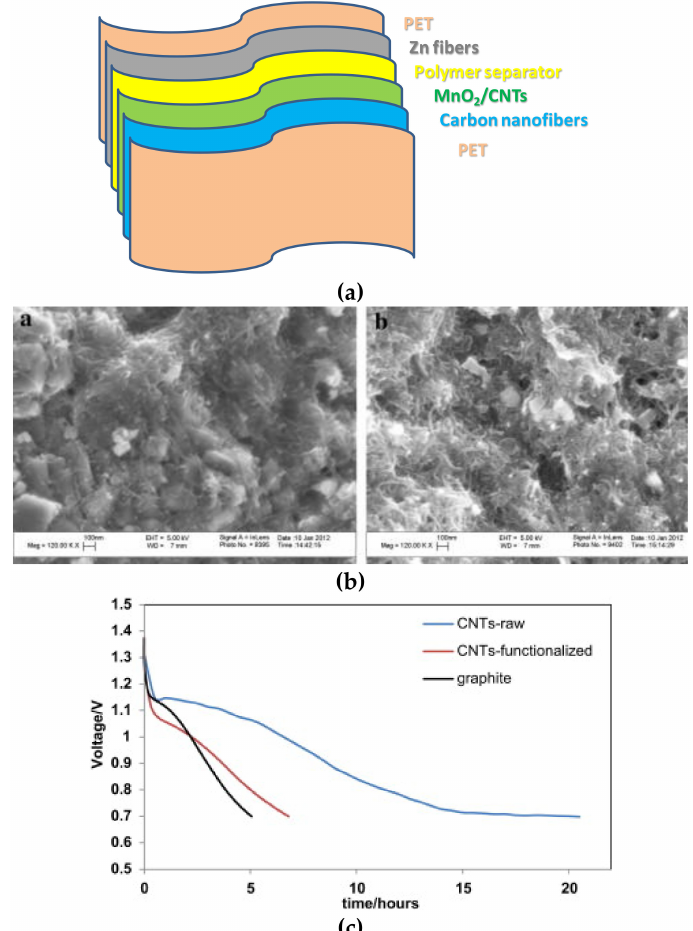
Figure 5. ( a ) Sketch of the typical components of a flexible Zn–carbon battery; ( b ) SEM micrographs of MnO 2 -cathode containing functionalized MWCNTs (left) and Zn particulate anode (right); ( c ) Zn–C discharge curves for di ff erent cathodes at the same load (8.6% w / w ). Panels ( b , c ) are reprinted from reference [146], copyright (2013), with permission from